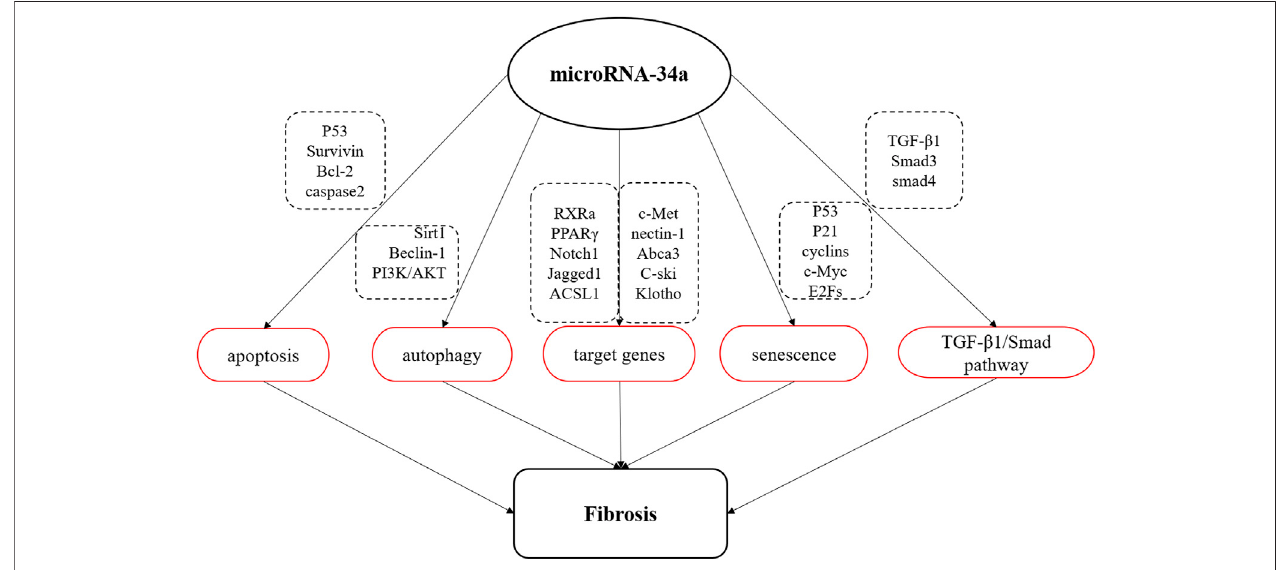
FIGURE1| SchematicdiagramofmiR-34ainvolvedin fi brosisprocess.MiR-34aisinvolvedintheapoptosis,autophagyandsenescence,regulatesTGF- β 1/Smad signal pathway, and negatively regulates the expression of multiple target genes to affect the process of organ fi brosis.